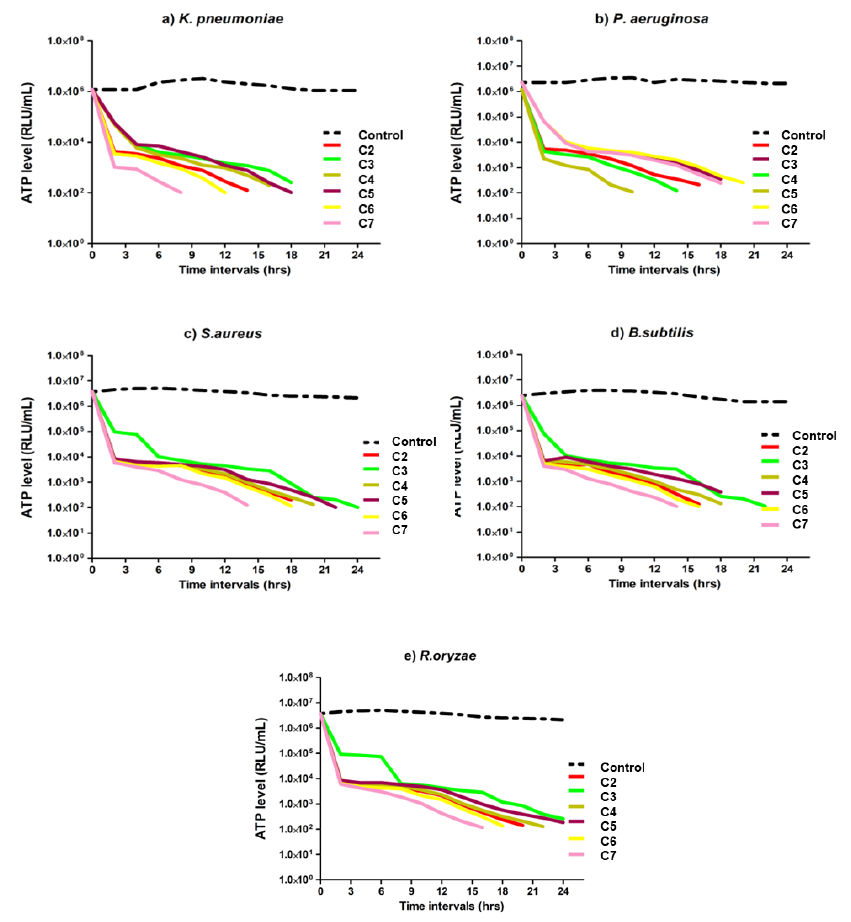
Figure 1. ATP level for ( a ) K. pneumoniae , ( b ) P. aeruginosa , ( c ) B. subtilis , ( d ) S. aureus , ( e ), R. oryzae before and after exposure to tested